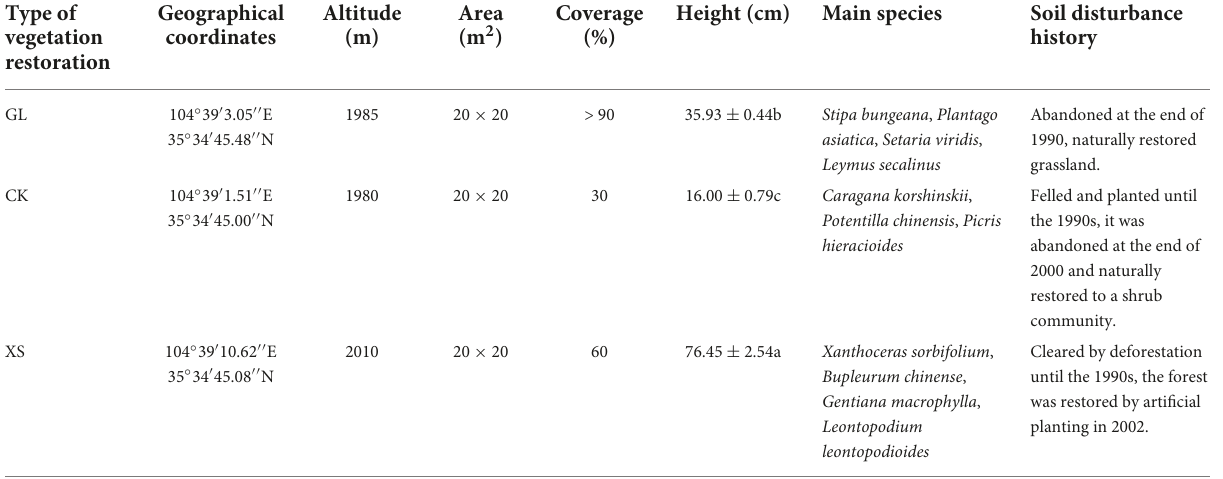
TABLE 1 Dominant species composition and land disturbance history of different vegetation restoration